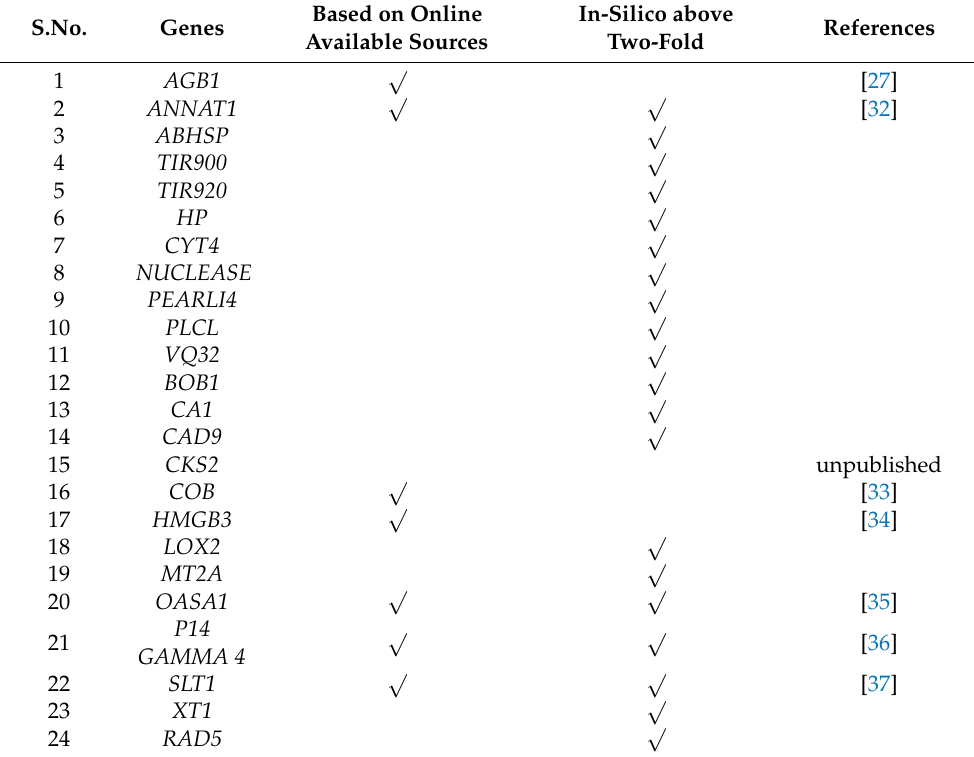
Table 2. NDL1 interactome showed twenty-four interactors specifically involved during salt stress responses. We refer to them as salt stress related putative interactors of NDL1 (SRPIN).